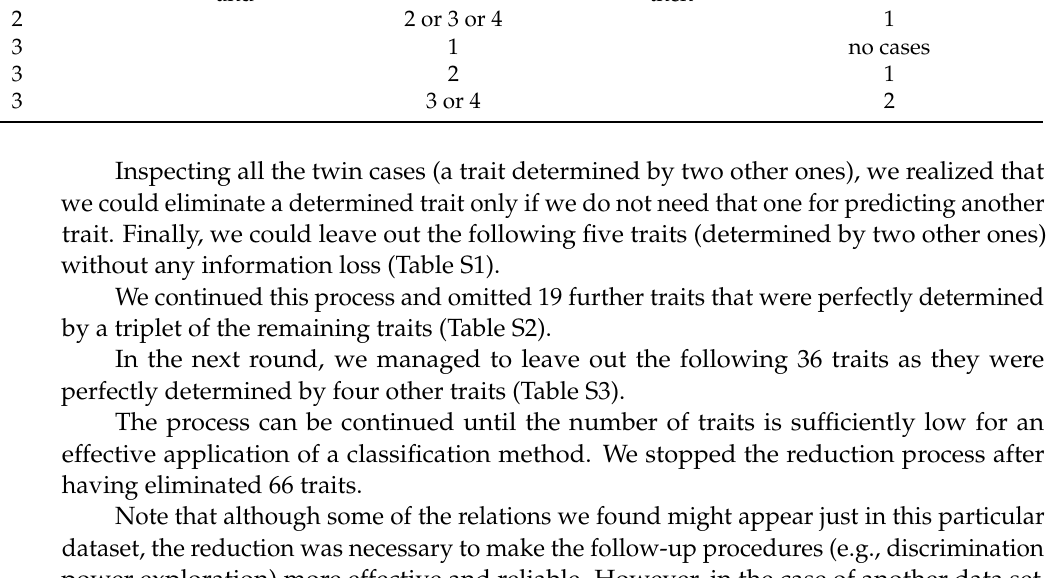
Table 7. An example of how two traits can determine another trait perfectly. Predictor Trait 1 Predictor Trait 2 Determined